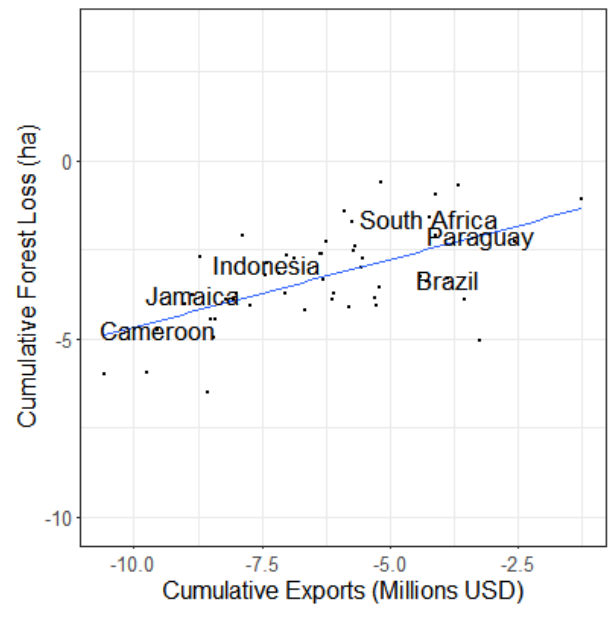
Fig. 6 . Linear regression of cumulative annual forest loss and cumulative soybean export value for pantropical countries (2000–2012). The cumulative sum of detected forest loss (Hansen et al. 2013; Fig A6.2) and soybean export value (Department of Economic and Social Affairs Statistics Division 2010, Food and Agriculture Organization of the United Nations 2016; Fig A6.3) by country were both normalized by the extent of forest with > 50% tree cover at the start of the period in the year 2000 (Fig. A6.1) and log (base 10)